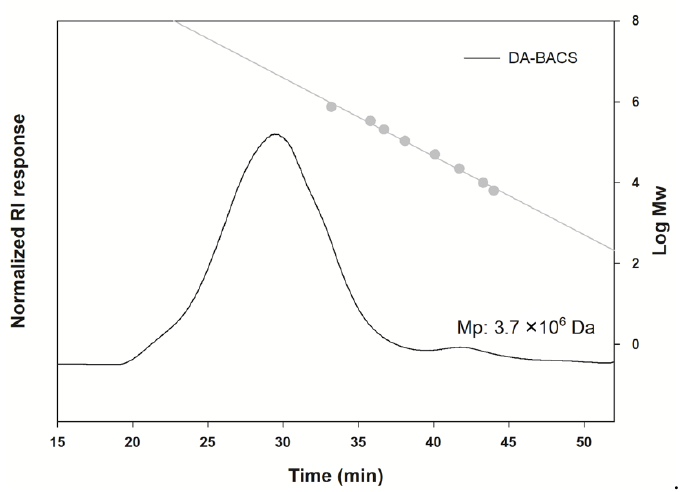
Figure 3. Molecular size distributions of EPS from L. paracasei EPS DA-BACS. Grey circles indicate pullulan standards.